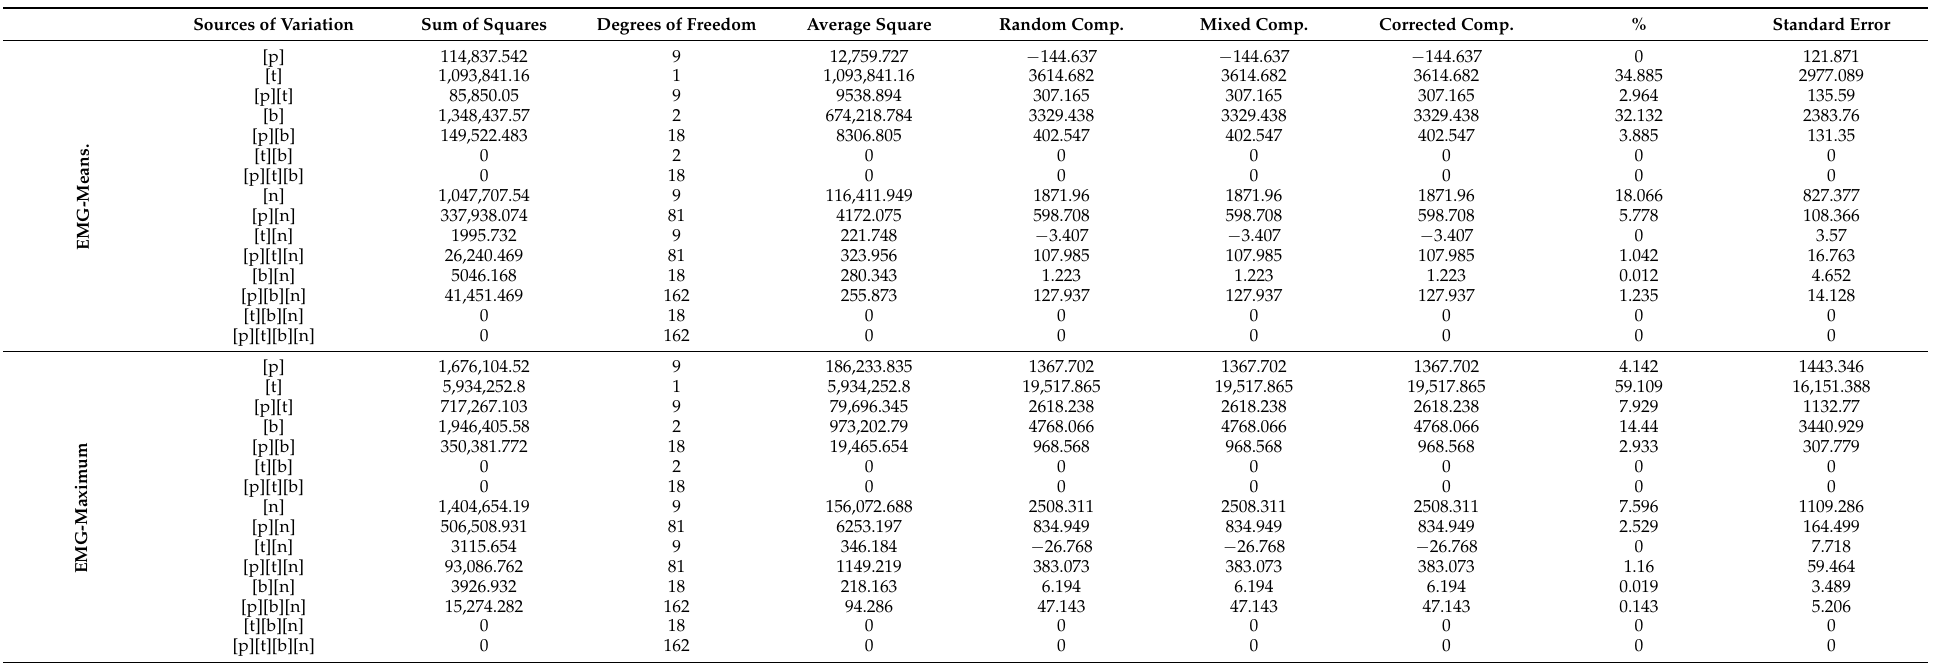
Table 1. Variance component